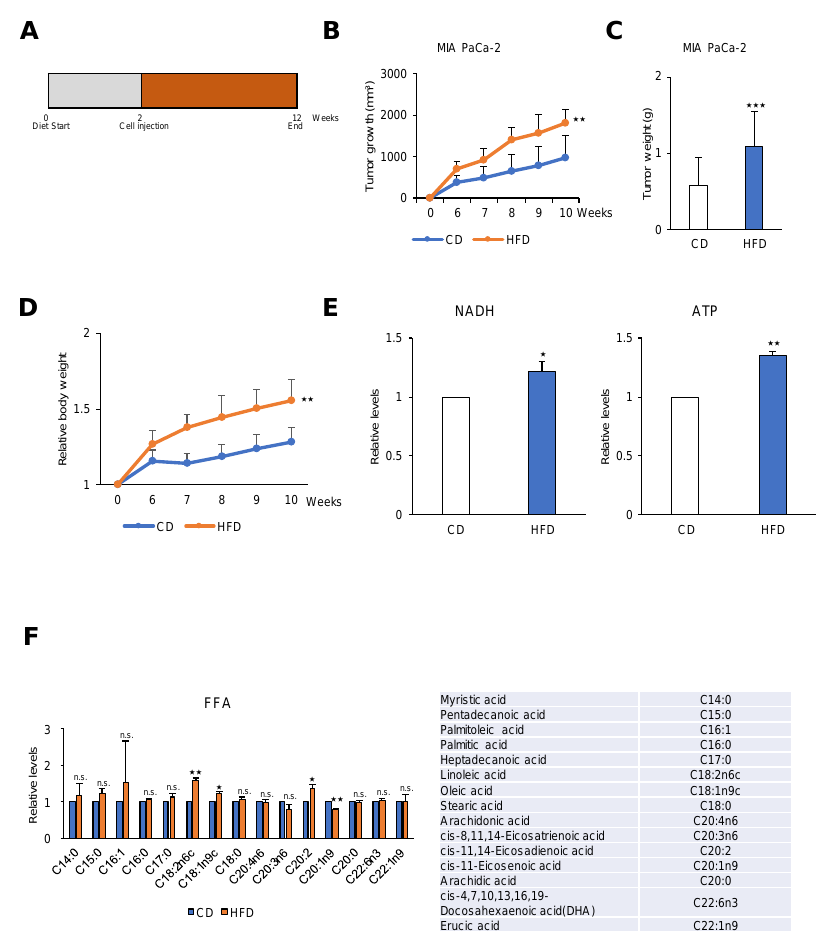
Figure 6. A high-fat diet increases tumor growth in a human pancreatic cancer xenograft mouse model. ( A ) MIA PaCa-2 (1 × 10 7 ) cells were injected into 6–8-week-old BALB/c nude mice ( n = 6 per group) exposed to a HFD or a CD for 12 weeks. ( B ) Tumor growth was measured using calipers. Tumor size is 2-fold greater in HFD group than in the CD group at 10 weeks. ( C ) Final weight of subcutaneous tumors derived from MIA PaCa-2 cells were measured. Tumor weight is 2-fold greater in HFD group than in the CD group at 10 weeks. ( D ) Effect of HFD on body weight in MIA PaCa-2 xenograft mouse model. ( E ) The levels of NADH and ATP were measured in CD and HFD groups by LC-MS/MS analysis. ( F ) Effect of HFD on metabolites in MIA PaCa-2 tumor tissues. Relative pool sizes of metabolites determined by targeted GC-MS. FFA, free-fatty acids; CD, control diet; HFD, high fat diet. * p < 0.05, ** p < 0.01, *** p < 0.001 compared with the control diet. n.s., not significant.